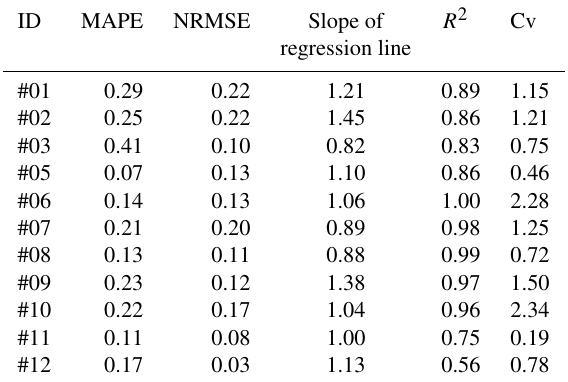
Table 4. Performances of the AVrain model that describes rain re- distribution by the solar panels, identifying each event (ID), indicat- ing the mean absolute percentage error (MAPE), normalized root mean square error (NRMSE), linear correlation coefficient and co- efficient of determination ( R 2 ) next to the simulated coefficients of variation (Cv). The highest Cv values signal the strongest spatial heterogeneities in rain redistribution by the solar panels.